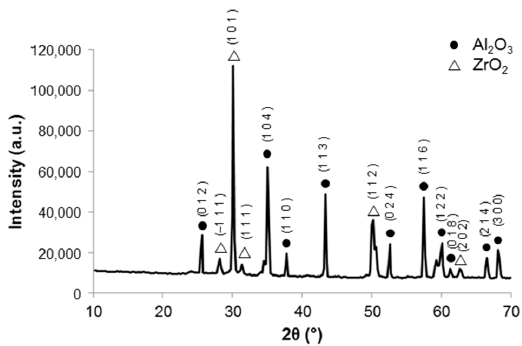
Figure 6. XRD pattern of a sintered ceramic sample.